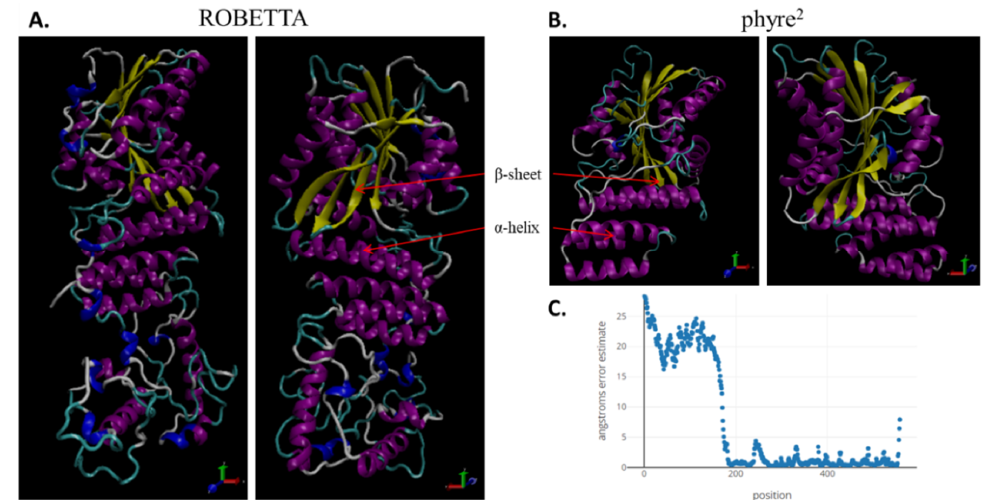
Figure 4. 3-D model of LlDELLA1 constructed by (A) ROBETTA and (B) phyre 2 protein modeling